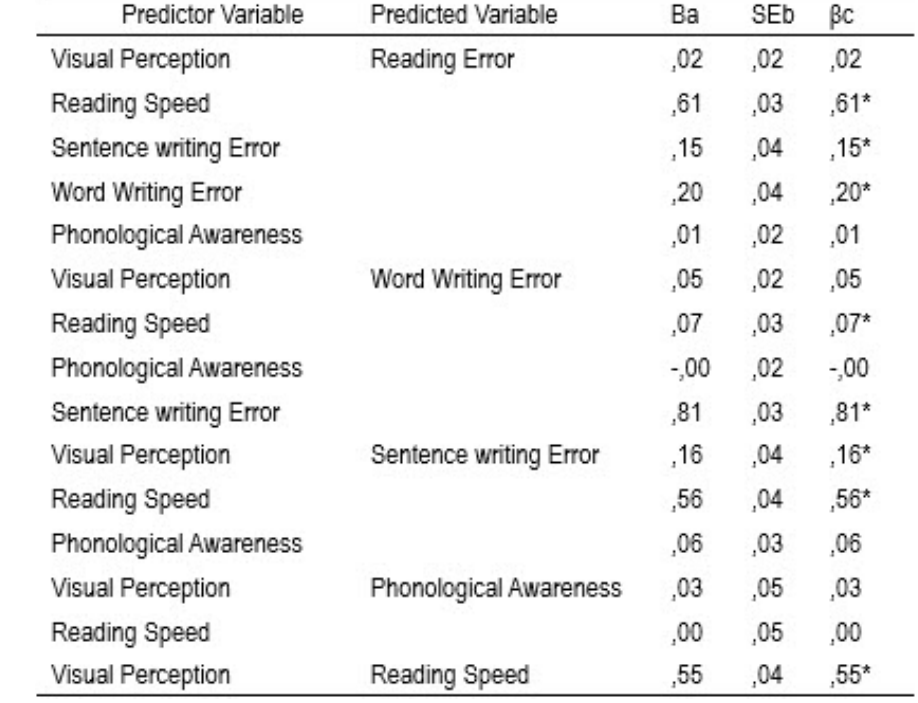
Direct effects of visual perception on phonological awareness, word writing error, reading error, and sentence writing